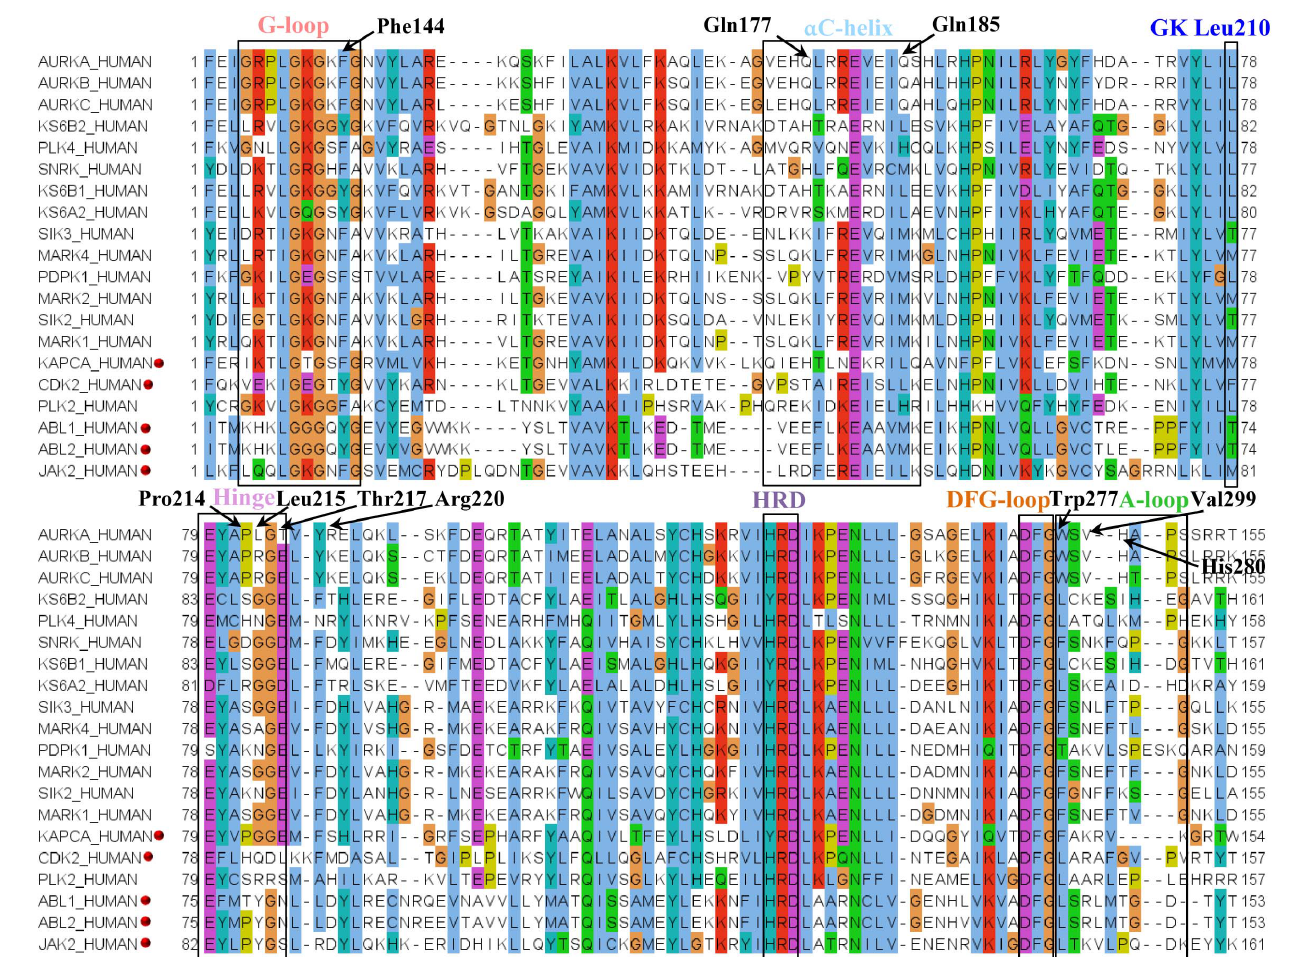
Figure 1. MSA of the kinase domains of AK and other sequentially similar kinases obtained from kinbase. A pairwise sequence alignment of the AK sequence (AURKA_HUMAN) against the annotated kinome present in Kinbase v1.1 was done using blast-p (Table S3 in File S2). The kinase domains of the sequentially similar sequences were retrieved from Kinbase v1.1 and a MSA was constructed with ClustalW 2.1. Jalview 2.8.0 has been used to view the alignment and the colour scheme is as per ClustalX. The red dots represent kinases which have been crystallized with different AK inhibitors (Table 2). The labelled residues indicate the possible sites for target specific inhibitor binding in AK based on